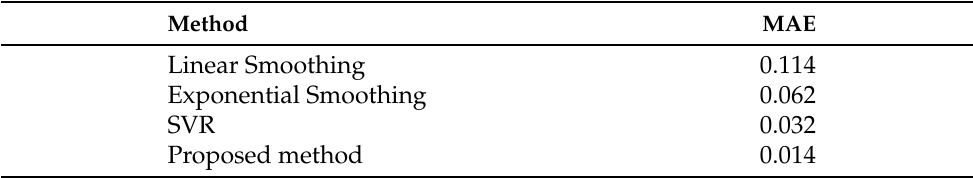
Table 4. MAE of Different Methods.